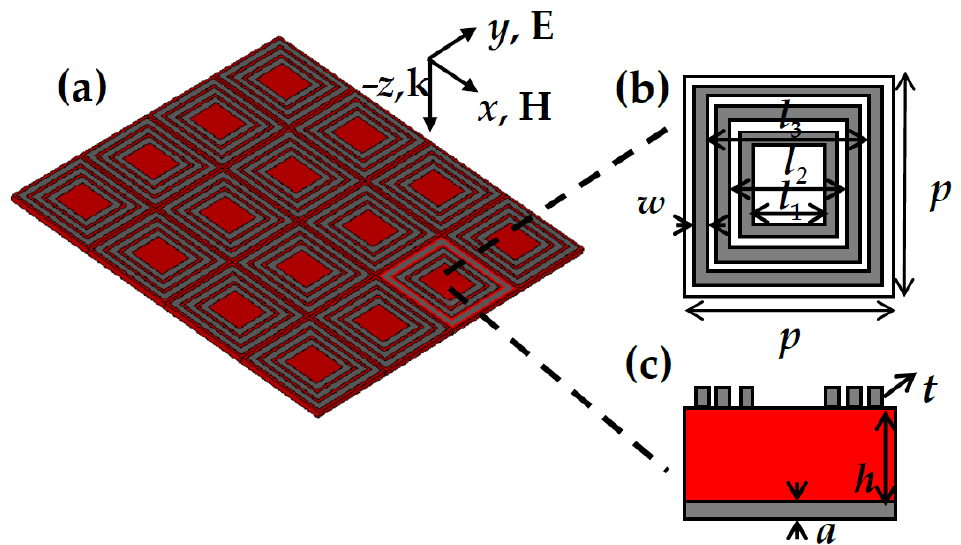
Figure 1. ( a ) Three-dimensional structure diagram of the absorber; ( b ) top and ( c ) side views of unit cell structure. The unit size is set as: w = 10 µ m, p = 150 µ m, l 1 = 60 µ m, l 2 = 90 µ m, l 3 = 120 µ m, t = 200 nm, h = 10 µ m, a = 200 nm.